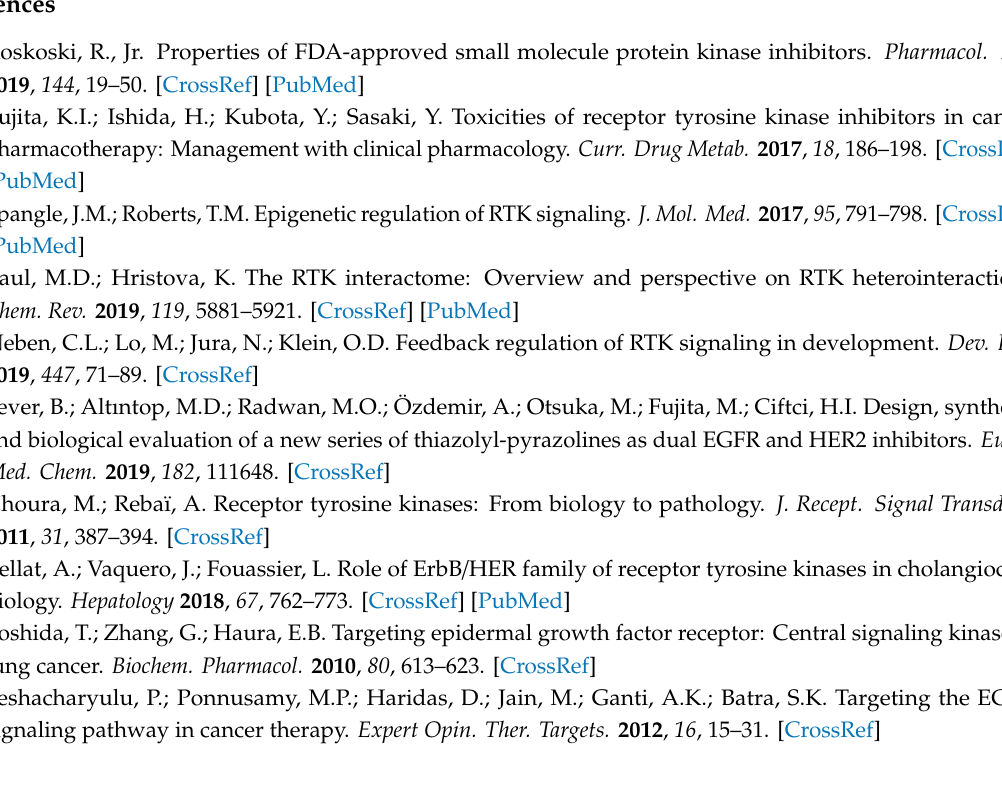
Supplementary Materials: Figure S1: IR spectrum of compound 2a , Figure S2: 1 H-NMR spectrum of compound 2a , Figure S3: 13 C-NMR spectrum of compound 2a , Figure S4: HRMS spectrum of compound 2a , Figure S5: IR spectrum of compound 2b , Figure S6: 1 H-NMR spectrum of compound 2b , Figure S7: 13 C-NMR spectrum of compound 2b , Figure S8: HRMS spectrum of compound 2b , Figure S9: IR spectrum of compound 2c , Figure S10: 1 H-NMR spectrum of compound 2c , Figure S11: 13 C-NMR spectrum of compound 2c , Figure S12: HRMS spectrum of compound 2c , Figure S13: IR spectrum of compound 2d , Figure S14: 1 H-NMR spectrum of compound 2d , Figure S15: 13 C-NMR spectrum of compound 2d , Figure S16: HRMS spectrum of compound 2d , Figure S17: IR spectrum of compound 2e , Figure S18: 1 H-NMR spectrum of compound 2e , Figure S19: 13 C-NMR spectrum of compound 2e , Figure S20: HRMS spectrum of compound 2e , Figure S21: IR spectrum of compound 2f , Figure S22: 1 H-NMR spectrum of compound 2f , Figure S23: 13 C-NMR spectrum of compound 2f , Figure S24: HRMS spectrum of compound 2f , Figure S25: IR spectrum of compound 2g , Figure S26: 1 H-NMR spectrum of compound 2g , Figure S27: 13 C-NMR spectrum of compound 2g , Figure S28: HRMS spectrum of compound 2g , Figure S29: IR spectrum of compound 2h , Figure S30: 1 H-NMR spectrum of compound 2h , Figure S31: 13 C-NMR spectrum of compound 2h , Figure S32: HRMS spectrum of compound 2h , Figure S33: IR spectrum of compound 2i , Figure S34: 1 H-NMR spectrum of compound 2i , Figure S35: 13 C-NMR spectrum of compound 2i , Figure S36: HRMS spectrum of compound